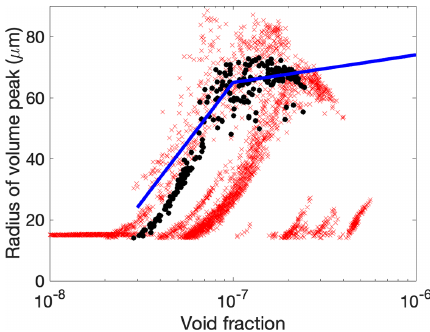
Figure 8. Comparison of the radius of peak volume with void frac- tion in the resonator data at 4m depth. The blue lines are identical to those in Fig. 7. Black dots show data from station 3 (18–21 Octo- ber) (with very low winds) and red crosses show data from station 6 (1–4 November). No data are shown for the later November de- ployment because there were no successful fits. These are all 1s fits, rather than the 10s averages shown above. Each short diagonal line is due to a single plume